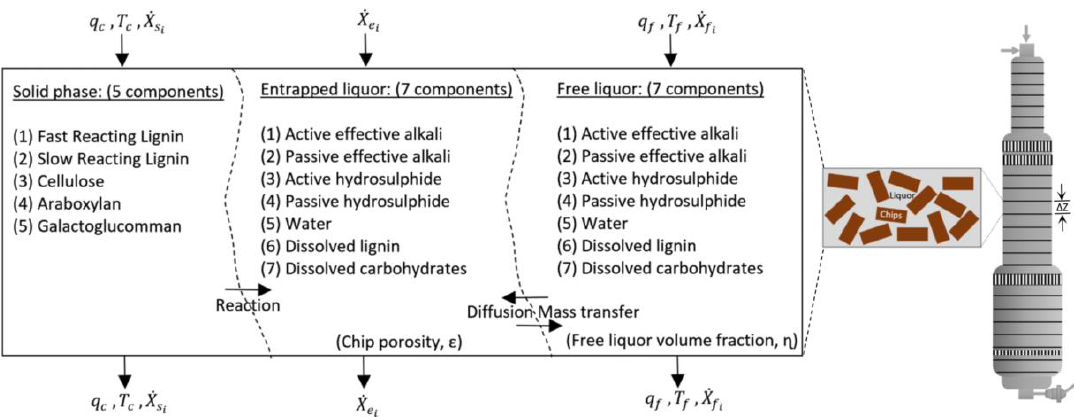
Figure 2. Conceptual outline of a continuous stirred-tank reactor (CSTR) located in the cooking zone. EA: E ff ective Alkali, HS: Hydrosulphide (adapted from